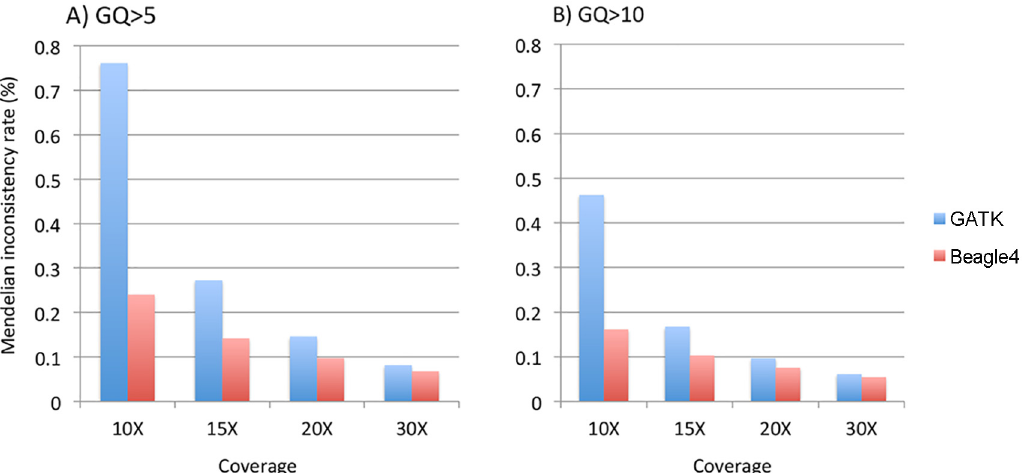
Fig 5. The average Mendelian inconsistency rates of Beagle4 and GATK calls per parents-offspring trio in the Nuc4 pedigrees at sequencing coverage of 10X, 15X, 20X when GQ = 5 (panel A) or GQ = 10 (panel B) was used to filter low quality